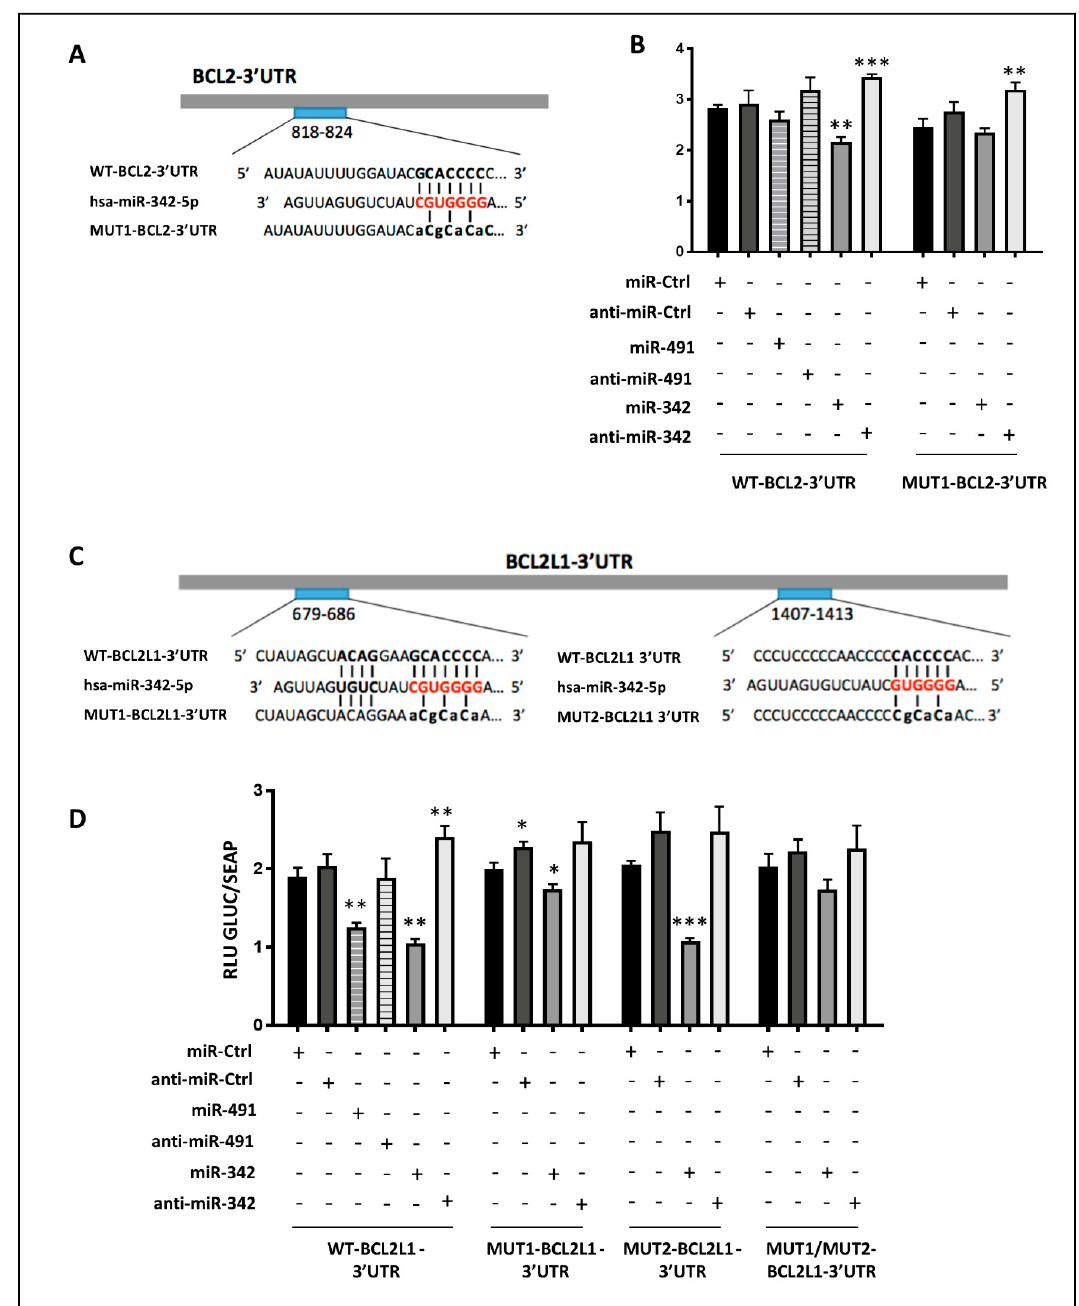
Figure 6 . Inhibition of both BCL2 and BCL2L1 mRNAs by miR-342-5p and of BCL2L1 mRNA by miR-491-5p. ( A ) The 3’UTR sequence of BCL2 was aligned with the conserved sequence complementary to hsa-miR-342-5p. Wild (WT) and mutant (MUT1) luciferase vectors of BCL2-3’UTR are shown. ( B ) WT and MUT1 reporter vectors of BCL2-3’UTR (0.25 ng/µL) were co-transfected with the indicated miR or anti-miR (20 nM) in SW1353 cells. ( C ) The 3’UTR sequences of BCL2L1 were aligned with the conserved sequence targeted by hsa-miR-342-5p. WT and mutants (MUT1, MUT2) luciferase vectors including BCL2L1-3’UTR are shown. The MUT1/MUT2-BCL2L1-3’UTR vector contains both mutations 1 and 2. ( D ) WT and mutant vectors of BCL2L1-3’UTR (1 ng/ µ L) were co-transfected with the indicated miR or anti-miR (20 nM) in SW1353 cells. ( B , D ) SEAP and GLUC luciferase activities were measured 24 h post-transfection. GLUC activity was normalized to SEAP activity and expressed as RLU. The data show a representative experiment (mean ± SD) of four independent experiments performed in triplicate. The significance of the results between miR-Ctrl and miRNA- or anti-miRNA-treated cells was evaluated by two-tailed Student’s t -test (*: p < 0.05, **: p < 0.01, ***: p <